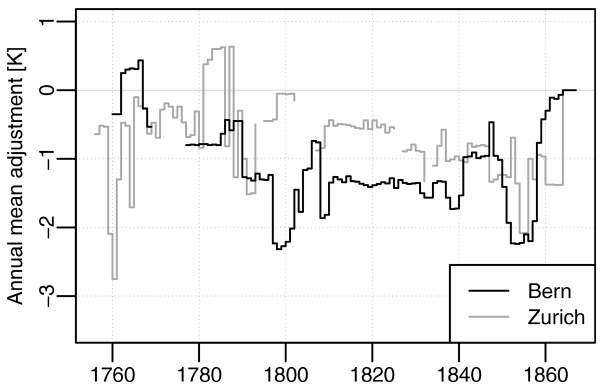
Figure 10. Time evolution of annual mean adjustments in the merged